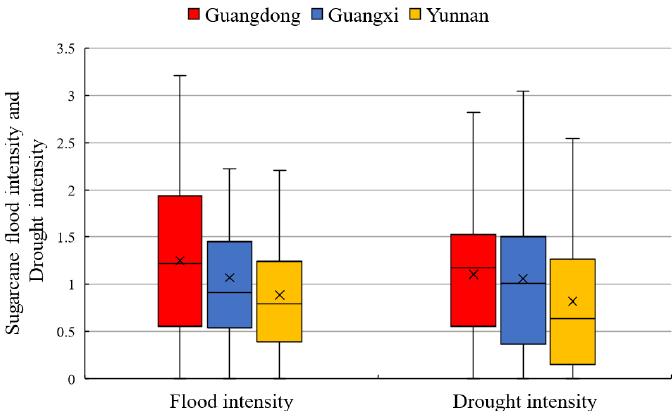
Figure 12. The intensities of drought and flood during sugarcane growth stages in SC from 1970 to 2020. × and — in the boxes represent the mean and median values, respectively.